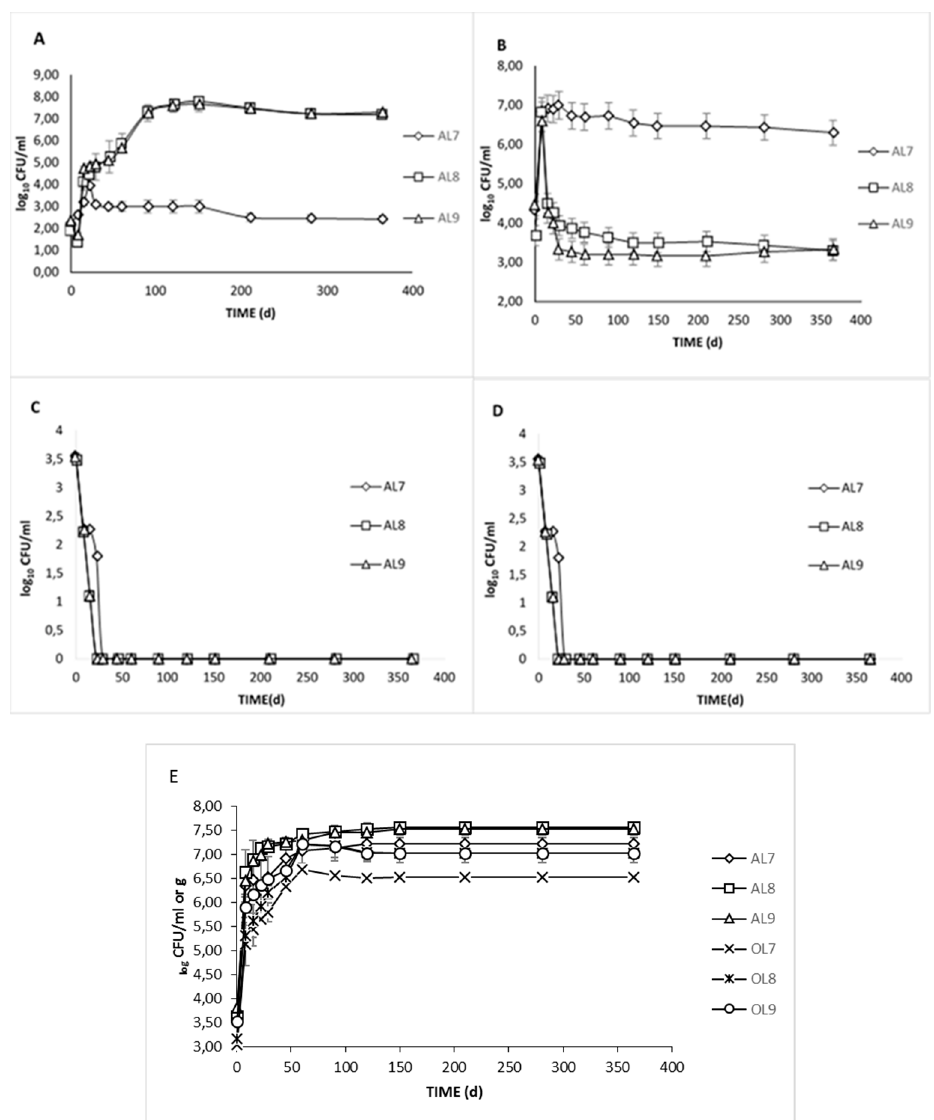
Figure 1. Evolution of microbial changes of spontaneous ( ◊ ), inoculated (10% NaCl) ( □ ), and inoculated (7% NaCl) ( ∆ ) fermentation of Cypriot green cracked table olives. LAB ( A ), Yeasts ( B ), Enterobacteriaceae ( C ), Coliforms , and ( D ) TVC (total viable count) ( E ). Data points expressed as log10 CFU/mL of 3 replicates ± standard deviation.